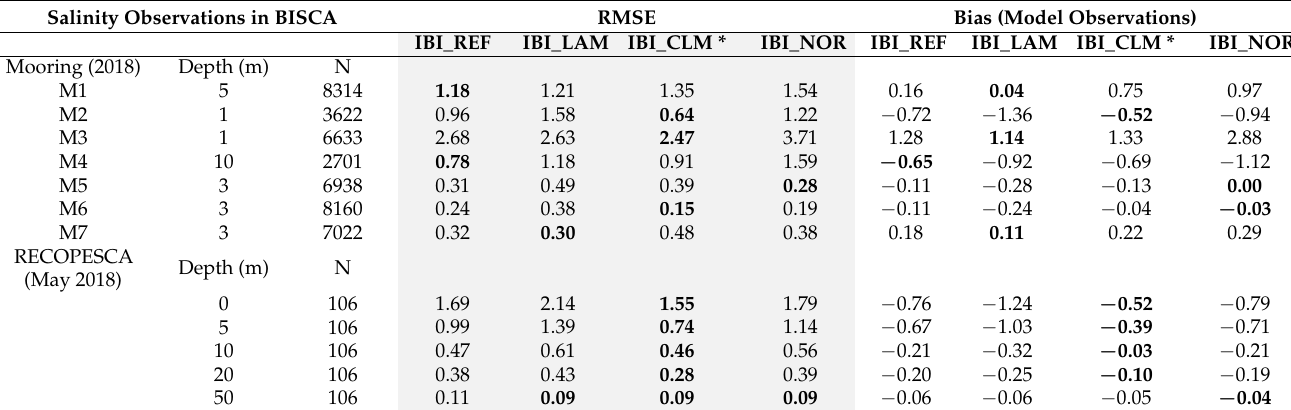
Table 5. Mean difference (Bias) and Root Mean Squared Error (RMSE) between observed salinity (from mooring buoys and RECOPESCA XBT profiles) and simulated one (from the IBI_REF, IBI_LAM, IBI_CLM, IBI_NOR model scenarios), over the respective length of the simulations, in the BISCA area. The smallest model bias and RMSE for each dataset are in bold. The mooring data have hourly frequency and RECOPESCA data daily frequency. N is the number of